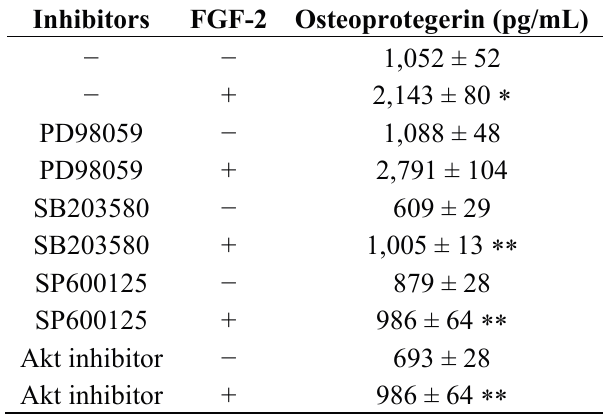
Table 2. The effects of PD98059, SB203580, SP600125 or the Akt inhibitor on the FGF-2-stimulated osteoprotegerin release in MC3T3-E1 cells. The cultured cells were pretreated with 50  M of PD98059, 30  M of SB203580, 10  M of SP600125, 30  M